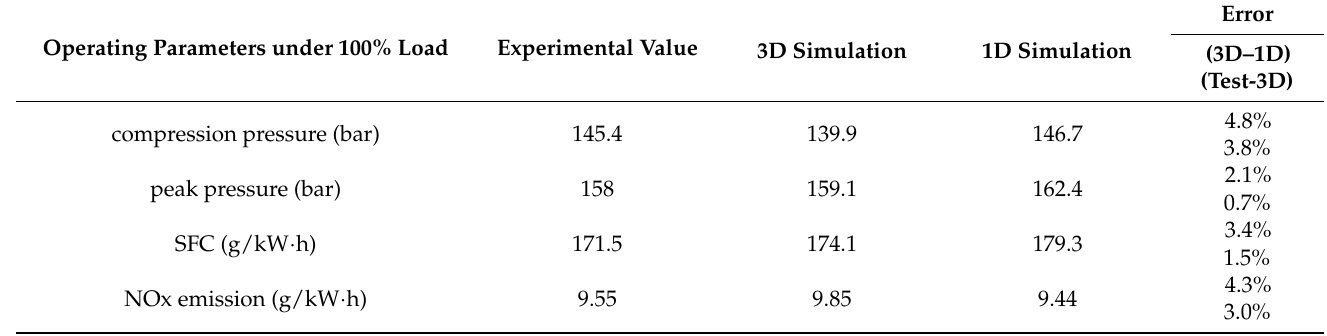
Table 8. Simulation calibration error under 100% load.